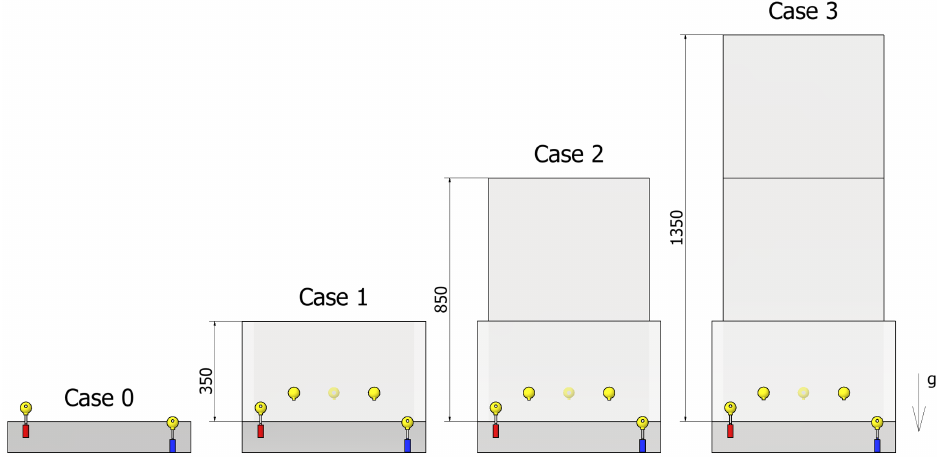
Figure 3. Tested variants of the chimney height above the heat exchanger; Case 0—without the chimney, Case 1—height of the chimney 350 mm, Case 2—height of the chimney 850 mm, and Case 3—height of the chimney 1350 mm.